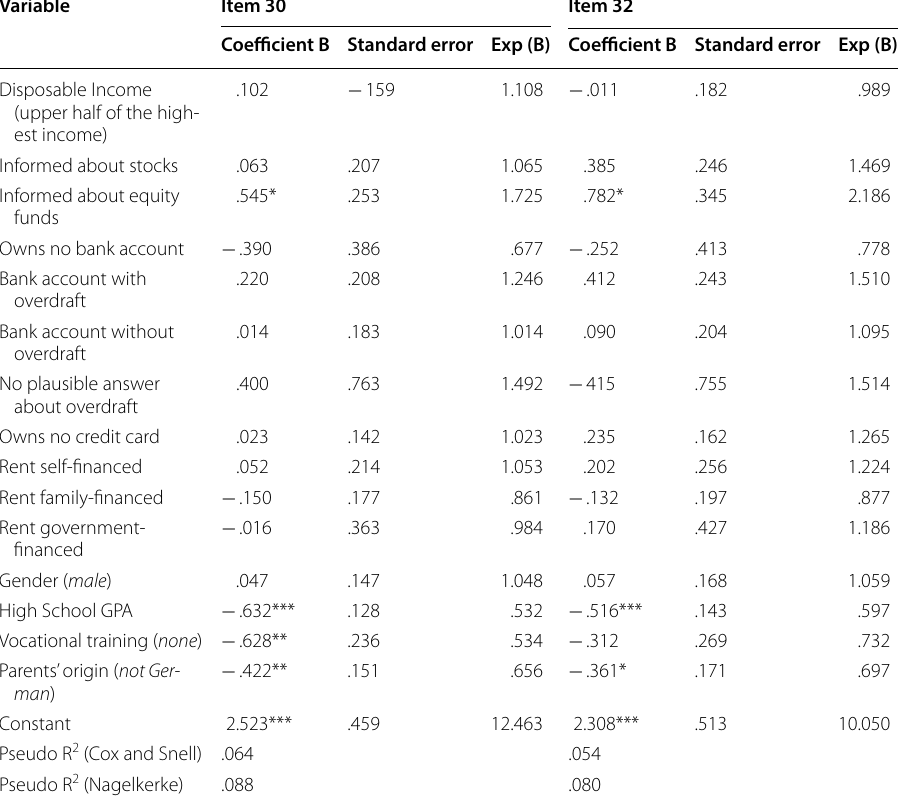
Table 6 Binary logistic regression on item 30 and item 32 of the